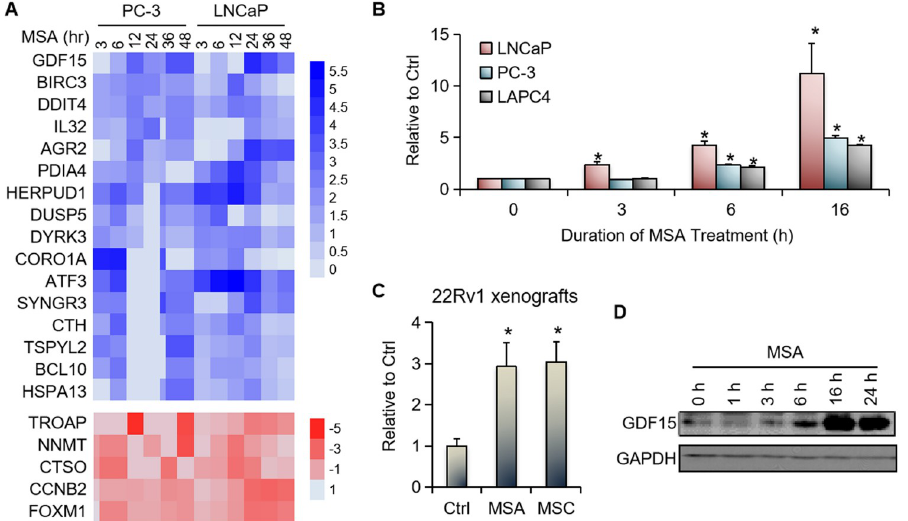
Fig 1. MSA upregulates the expression of GDF15. A . Microarray data showing GDF15 as one of the most highly induced genes by MSA in both PC-3 and LNCaP cells. Shown are all the genes that are modulated by MSA by at least a mean of 2 fold in both cell models. Colors indicate log2-transformed fold of change after MSA treatment. B . qRT-PCR analysis confirming MSA induction of GDF15 mRNA level in cultured cells. C . qRT-PCR showing induction of GDF15 mRNA level by MSA and MSC in 22Rv1 xenograft tumors (n = 3 for the control group; n = 4 for the MSA and MSC groups). D . Western blotting showing MSA induction of GDF15 protein level in LNCaP cells. All MSA treatment of cultured cells is at 10 μ M. Bars, SEM. � , P < 0.05 from control using Student’s t test.